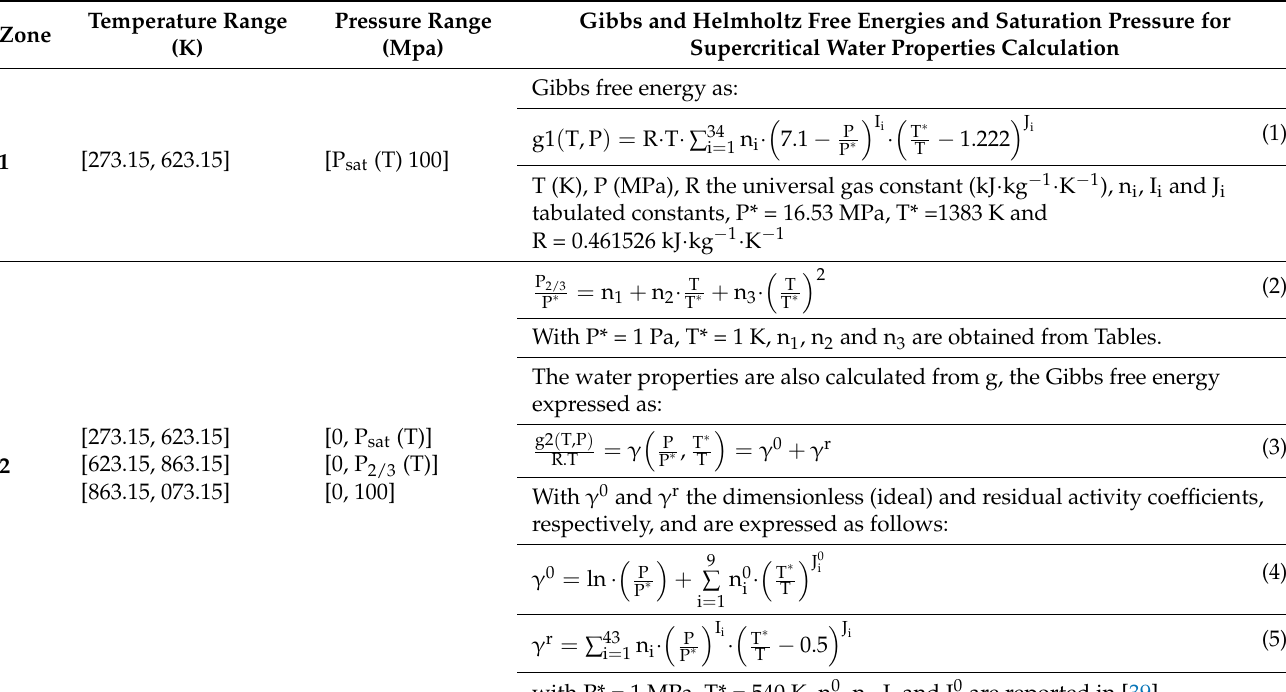
Figure 2. The five regions and equations of IAPWS-IF97 [39]. Table 1. Equations for calculation of supercritical water properties .